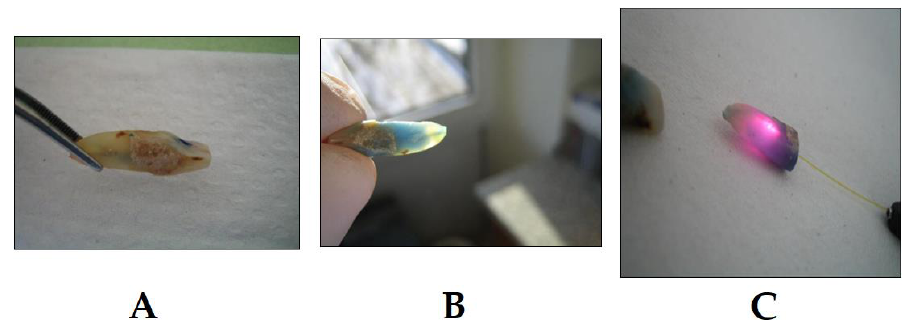
Figure 4. Example of PDT in endodontic treatment (photo courtesy of R. Szab ó DMD, J. Arentz DMD and T. Nave DMD). ( A ) Extracted lower incisor after chemo-mechanical preparation and application of the PS into the canal; ( B ) penetration of the PS into the canal, 7 h after application, the PS already shows penetration into the apical region and lateral canals; and ( C ) treatment with laser light; the PDT light system is able to align the laser light in a way to allow for the activation of as many as possible PSs inside the canal to achieve the optimum e ff ect. Following this step, root canals may be obturated. Dent. J. 2020 , 8 , x FOR PEER REVIEW